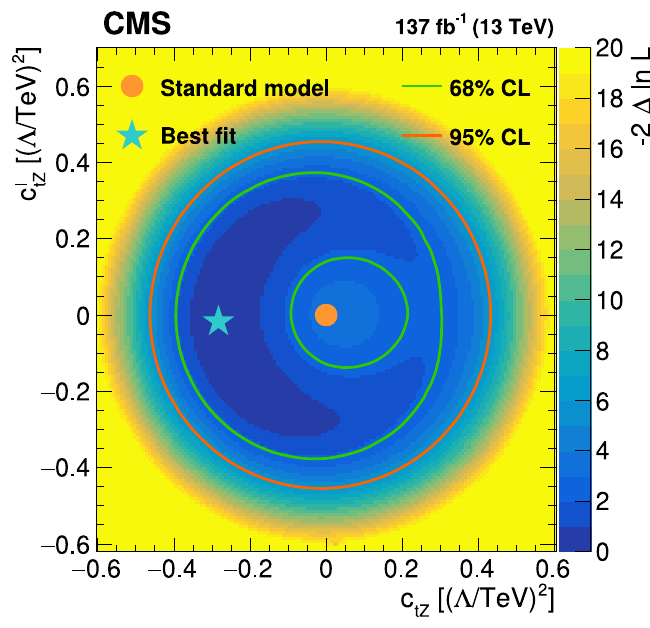
and c I . The shading tZ tZ